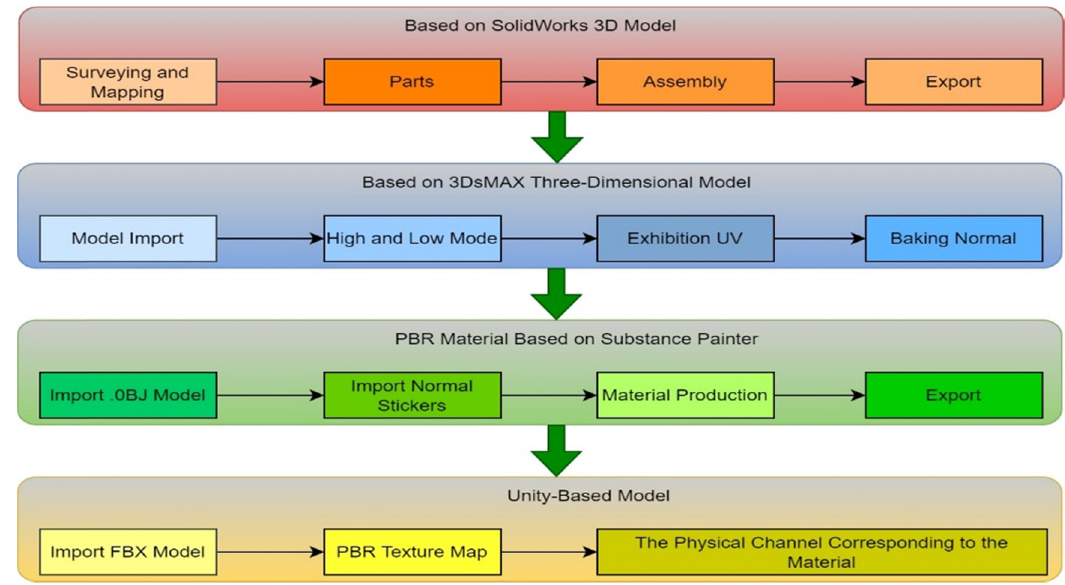
Figure 6: VR model development route.